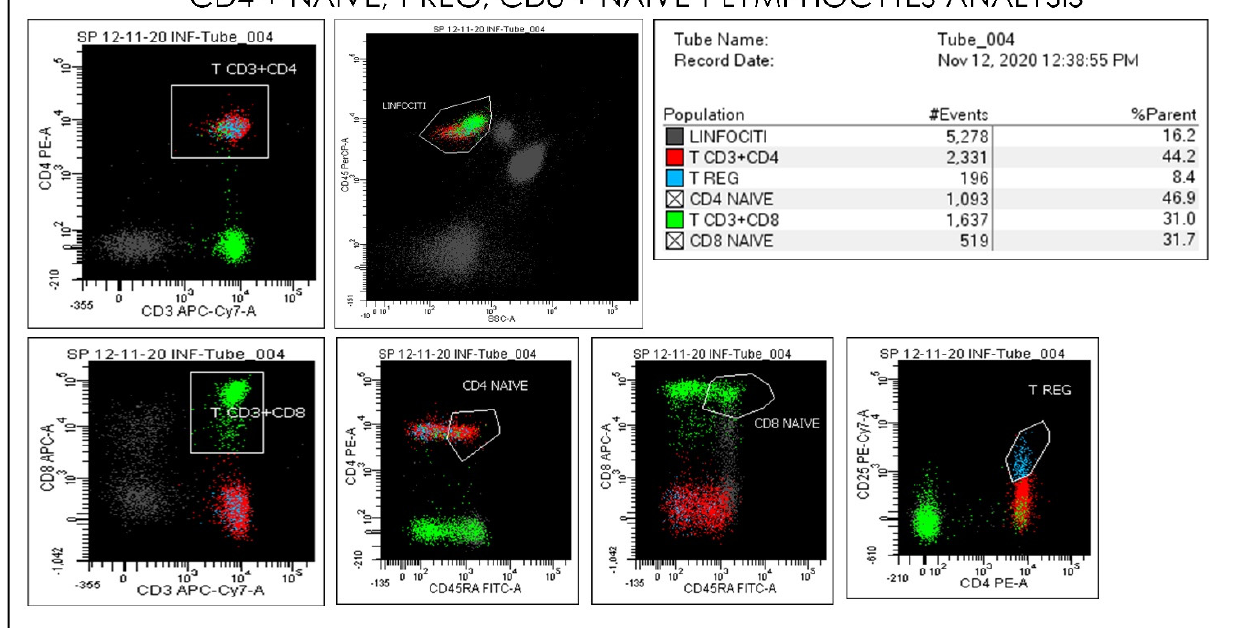
Figure 12. Gating Strategy for Lymphocytes, CD4 naïve, CD8 naïve, T reg, CD3+CD8+ quantification. A doublet exclusion gate based upon (FSC-A vs. FSC-H) was utilized to gate on singlet cells, and within this singlet cell gate a lymphocyte